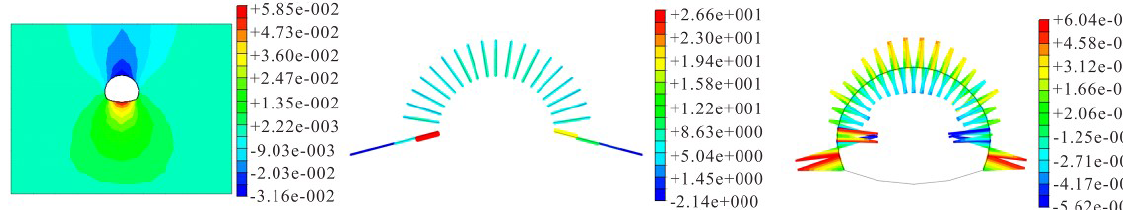
Figure 5. Working Condition 4: vertical displacement of the surrounding rock (mm), moment of shotcrete (KNm), and axial force of the anchor rod and cantilever beam (KN).